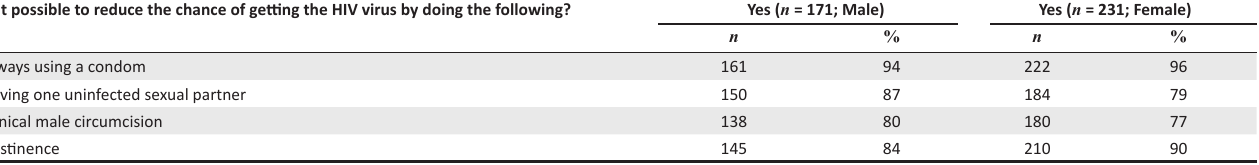
TABLE 3: Students perceived HIV and/or AIDS prevention knowledge and/or strategies. Is it possible to reduce the chance of getting the HIV virus by doing the